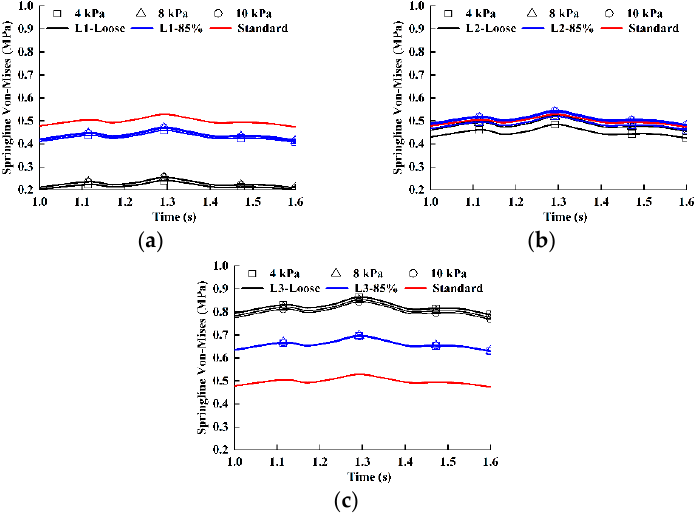
Figure 18. The springline Von-Mises stresses of pipes of different hoop stiffness under traffic load: ( a ) change in L1 compaction degree; ( b ) change in L2 compaction degree; ( c ) change in L3 compaction degree.